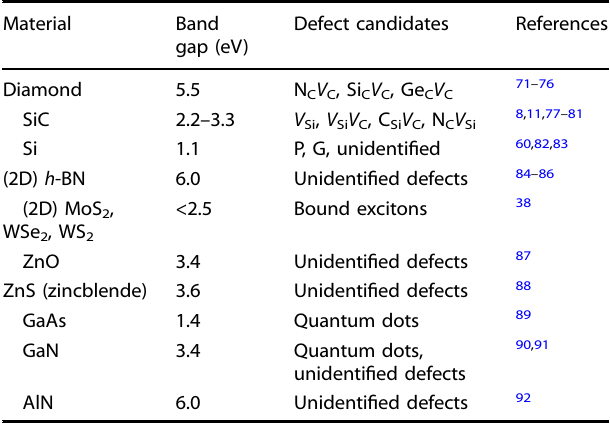
The materials have demonstrated quantum compatible characteristics such as single-photon emission and coherent spin manipulation. The subscript denotes lattice site and V refers to a